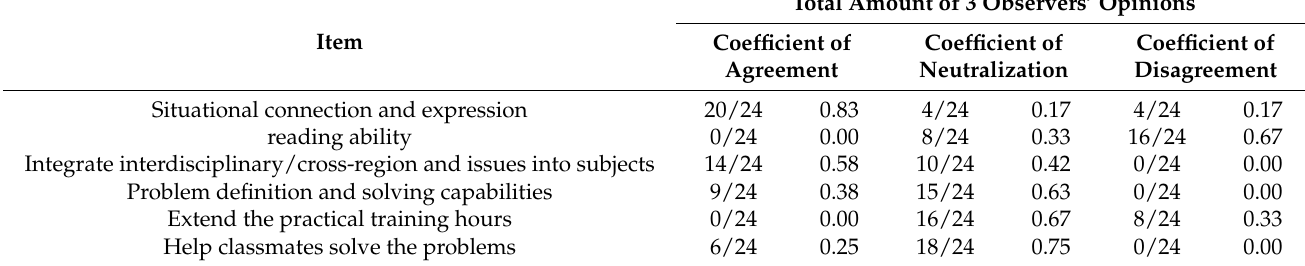
Table 23. Statistical table of a collection of organized, qualitative data including observational coefficients and common opinions that were gathered during competence-oriented instructional strategy